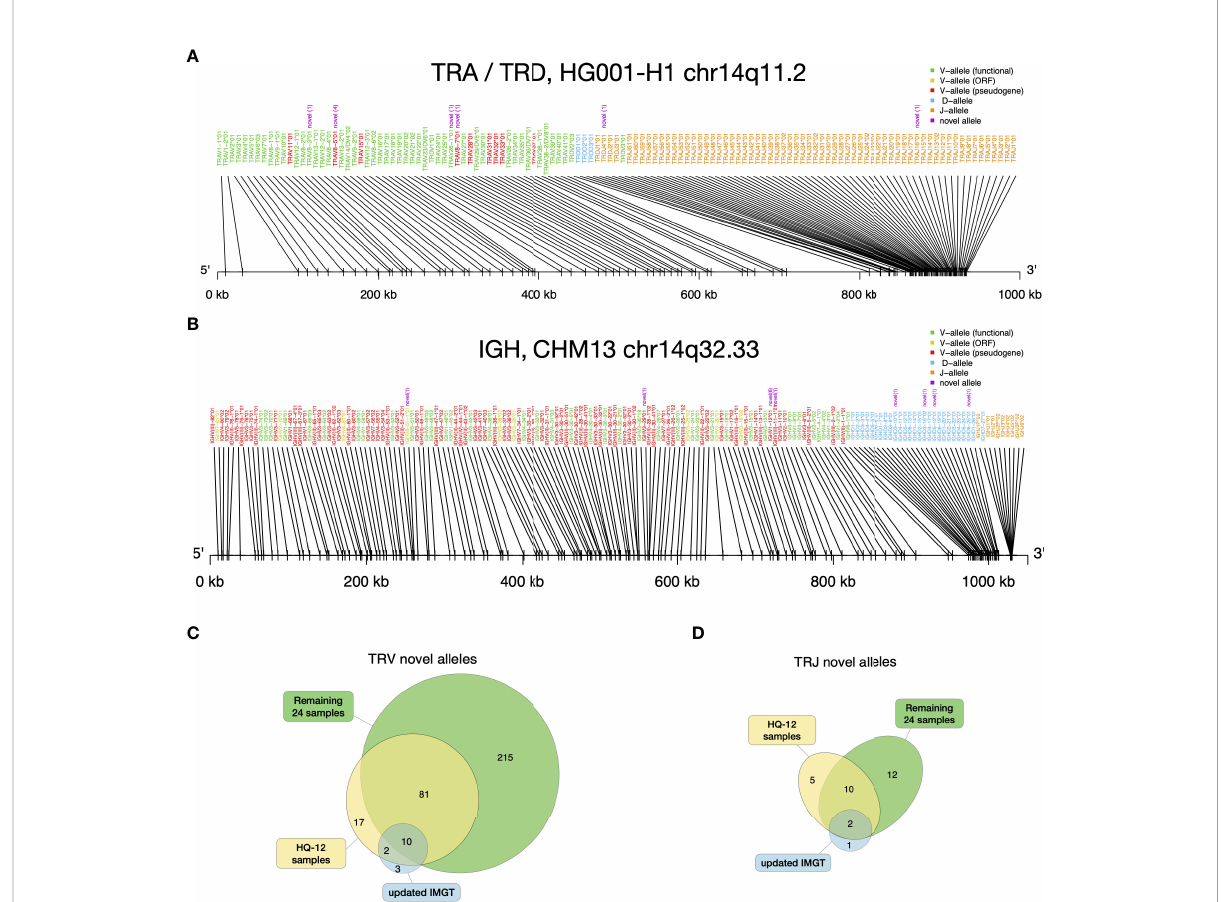
FIGURE 4 gAIRR-annotate results. (A) Positions of HG001 ’ s TRA and TRD alleles determined by gAIRR-annotate. The purple text indicates that the allele is novel with its edit-distance compared to the most similar base allele inside parentheses. The text color of the gene names are basically according to IMGT ’ s color menu for genes (5). (B) Positions of CHM13 (36) IGH alleles determined by gAIRR-annotated. The fi gure settings are the same as in (A) . (C) TRV and (D) TRJ novel alleles found in HQ-12 samples (shown in yellow) and remaining 24 samples (shown in green) compared to the novel alleles updated in IMGT from v3.1.22 to